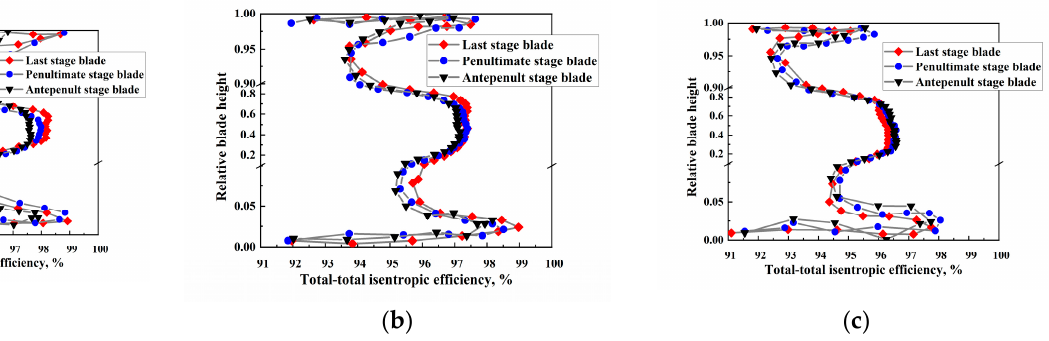
Figure 12. Distribution of the total-total isentropic efficiency along the blade height (1.9 MPa back pressure): ( a ) 85% load ratio; ( b ) 60% load ratio; ( c ) 40% load